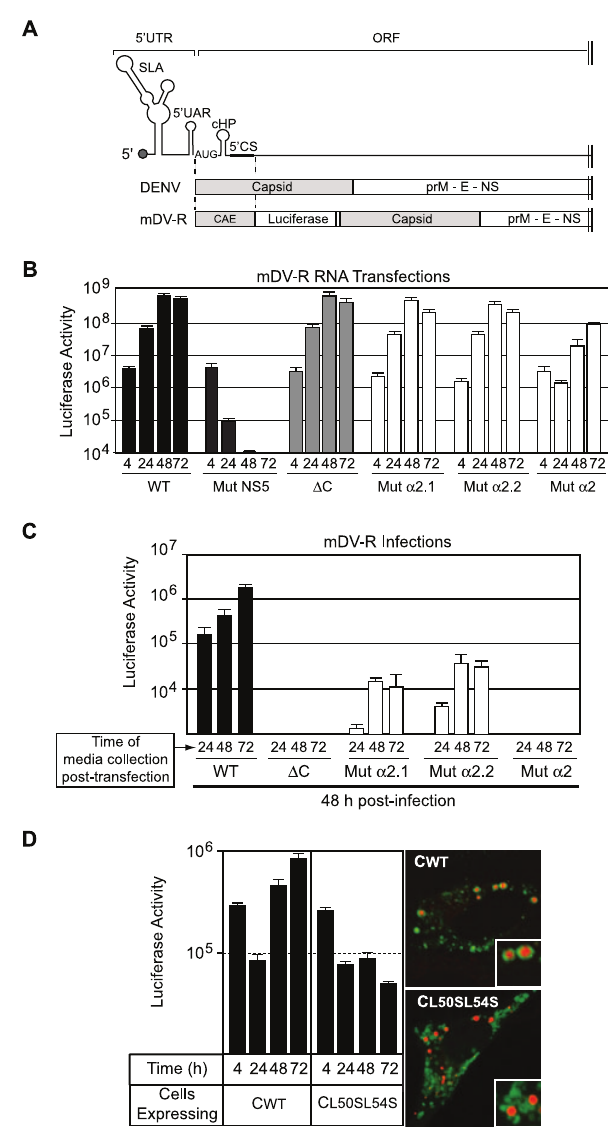
Figure 6. A new reporter virus that allows dissociation of cis- acting RNA elements from the capsid coding region confirms a role of L50 and L54 in DENV particle formation. A. Construction of a novel monocistronic DENV reporter system. At the top, schematic representation of the cis-acting replication elements located at the 5 9 end of the DENV genome. The promoter stem-loop A (SLA), the cyclization sequence upstream of the AUG (5 9 UAR), the replication element cHP, and the cyclization sequence 5 9 CS are indicated. In the middle, the corresponding region of DENV polyprotein is shown. At the bottom, a schematic representation of the monocistronic DENV reporter construct (mDV-R) showing the duplication of the cis-acting elements (CAE) and the location of the luciferase and the viral proteins. B. Translation and replication of mutant mDV-R RNAs. BHK cells were transfected with DENV RNAs corresponding to the mDV-R WT, Mut D C with the complete deletion of C coding sequence, Mut a 2.1, Mut a 2.2, Mut a 2, and Mut NS5, which carries a mutation in the catalytic GDD motif of the viral polymerase. Luciferase activity was measured as a function of time for each RNA as indicated at the bottom. C. Mutations in the a 2 helix of the C protein impair viral particle formation. The media of the transfected cells from the experiment shown in B was collected at the indicated times and used to infect fresh cells. Luciferase activity was measured 48 h post-infection for each virus as indicated at the bottom. D. A matured form of C L50SL54S protein expressed in